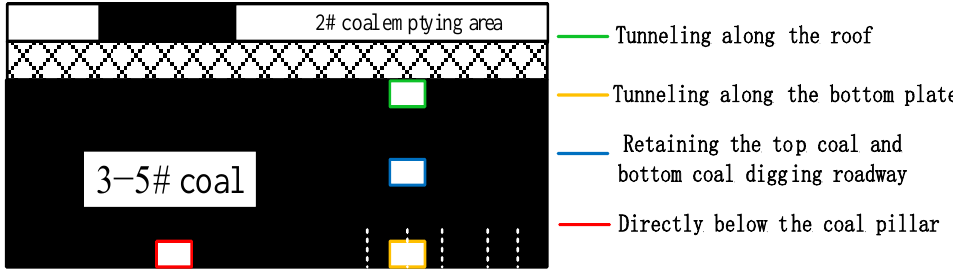
Figure 5. Numerical model perspective view. Table 1. Rock mechanics parameter table. Parameters Lithology